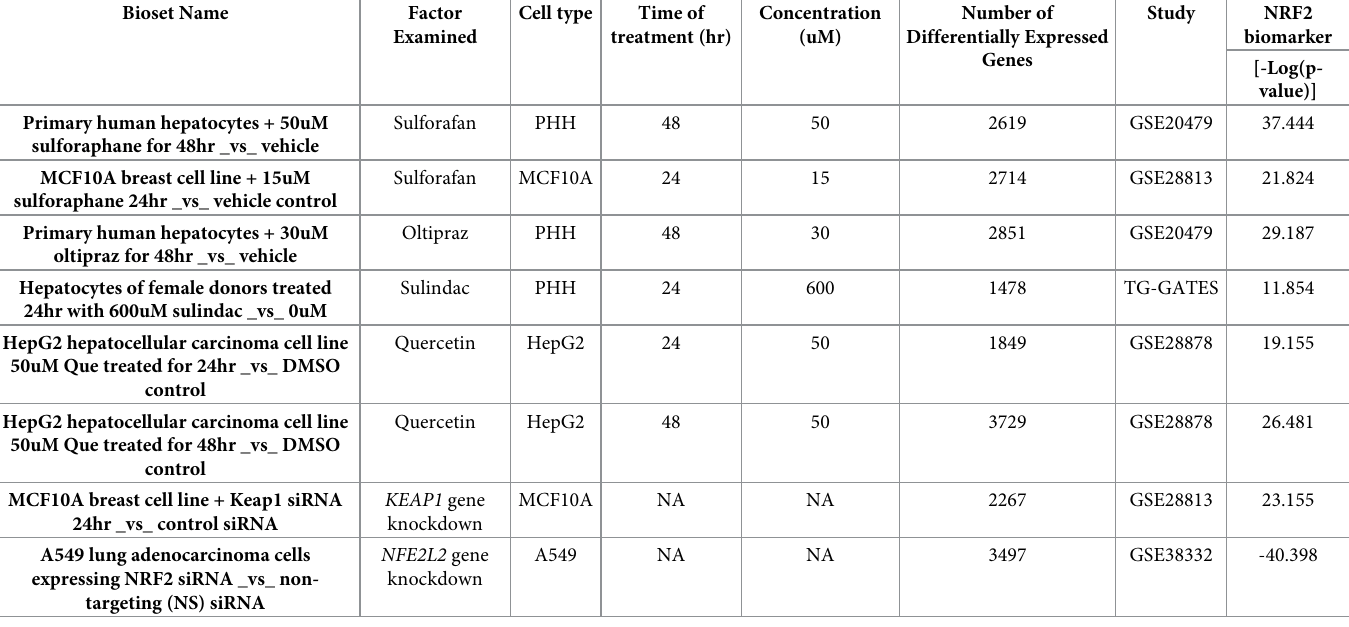
Table 1. Biosets used to build the NRF2